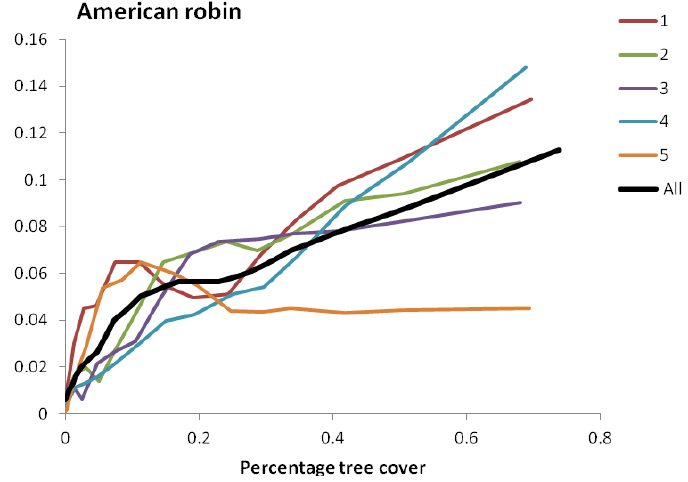
Figure A1.2 Incidence plots calculated using subsamples of the data and all data for American